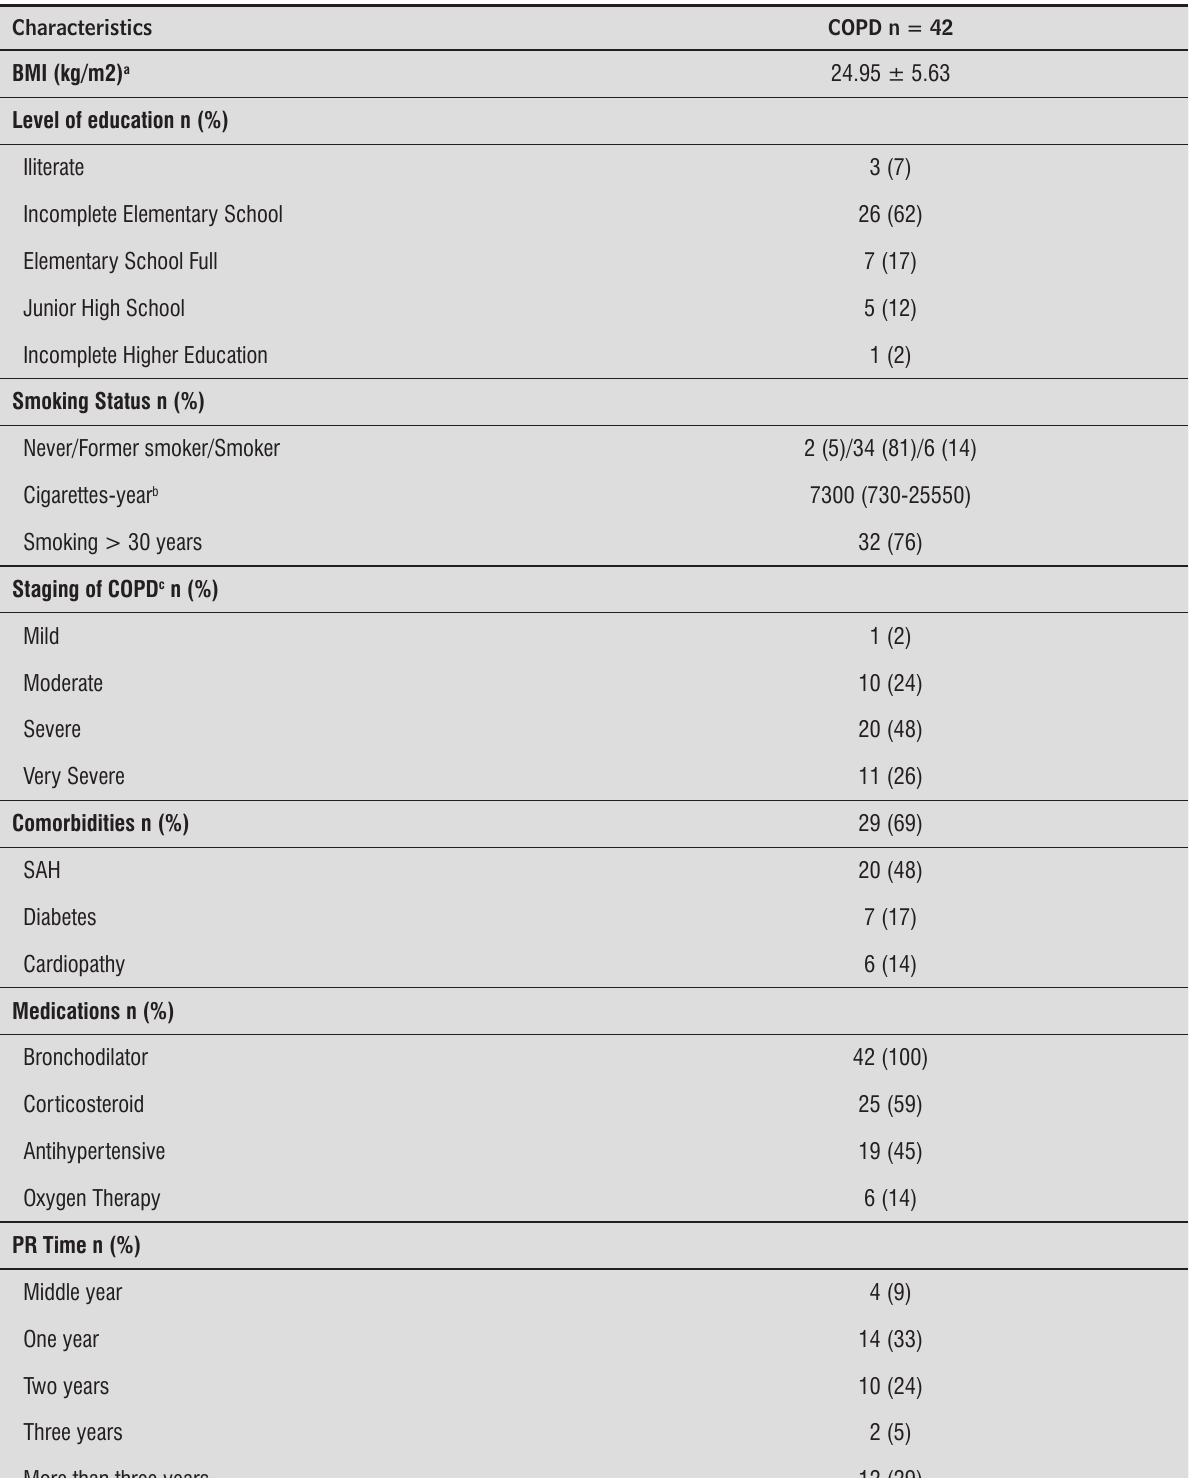
Table 1 - Clinical characteristics and education of patients with COPD, staging of COPD, comorbidities and treatments